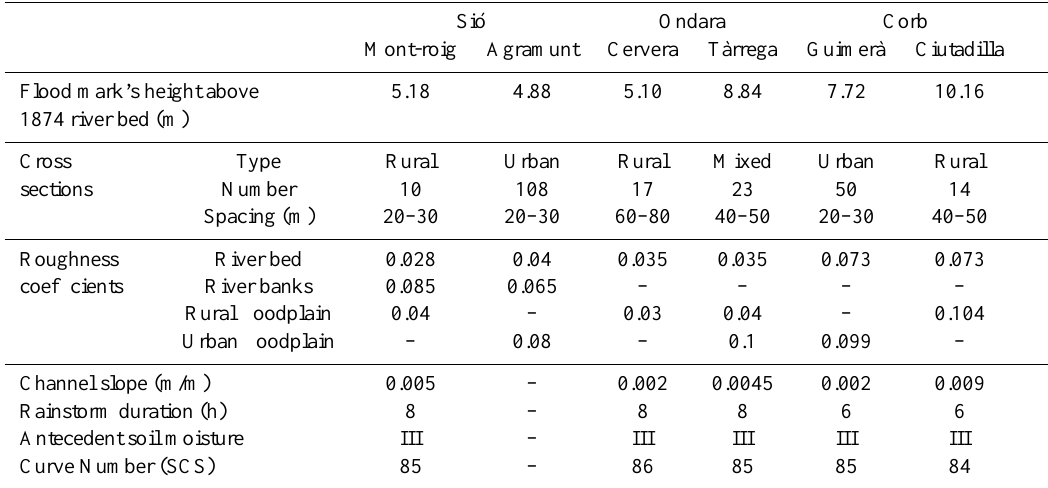
Table 2. Input data used in the hydraulic and in the hydrological modelling.